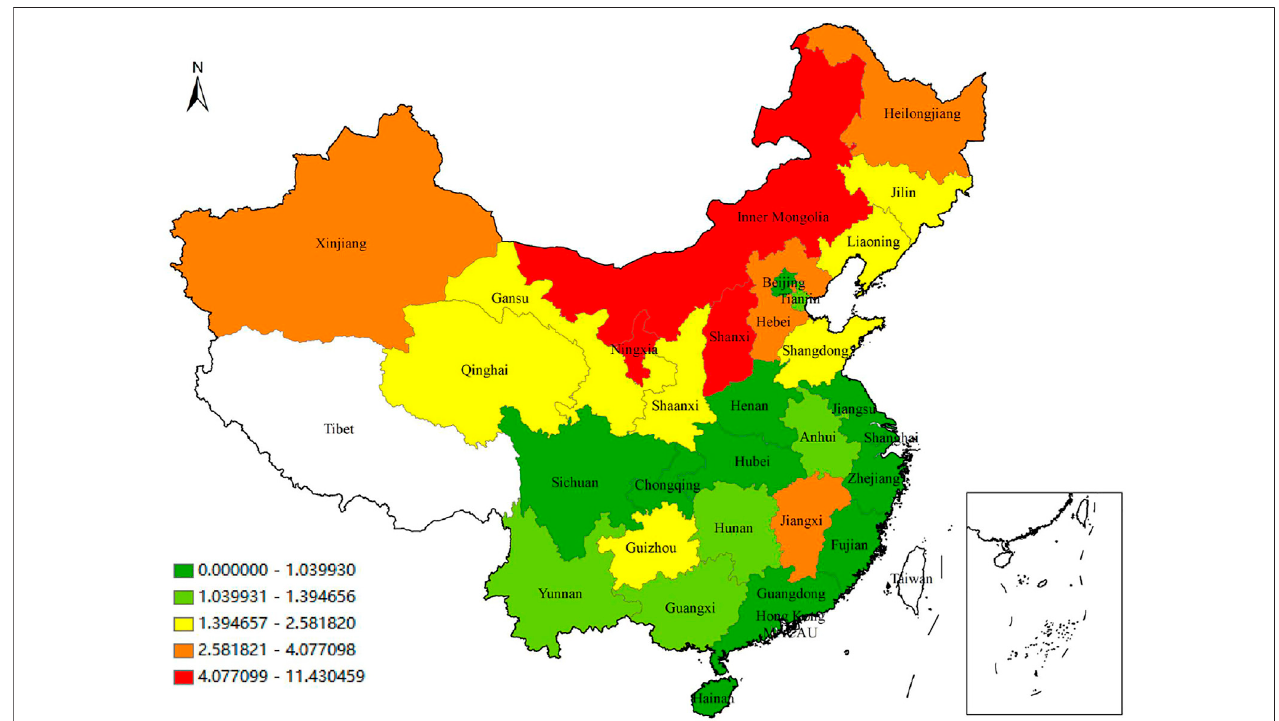
FIGURE 2 | Distribution map of carbon emission intensity in